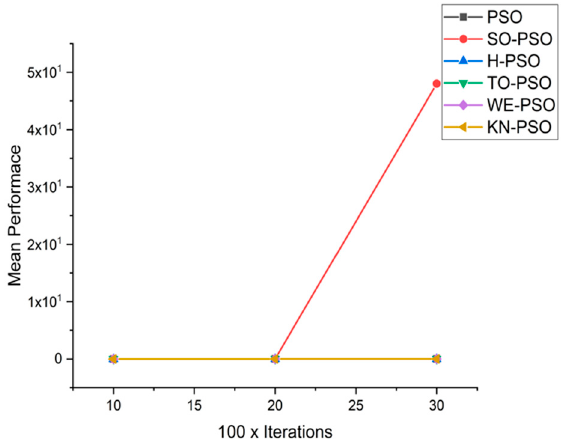
Figure 19. Convergence curve on fn13.